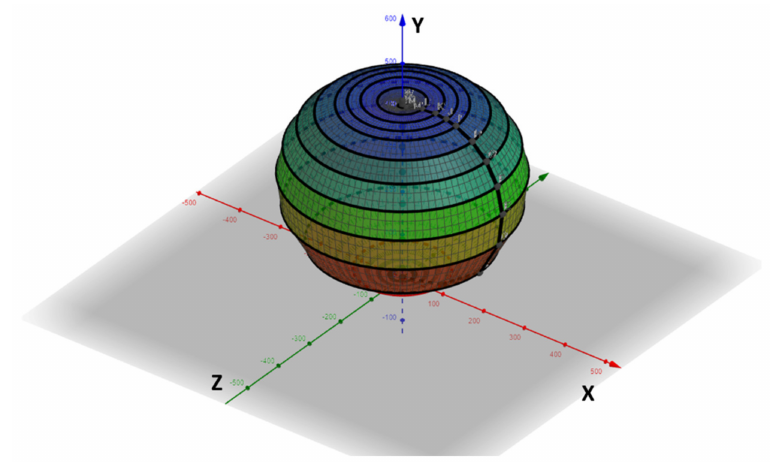
Figure 10. The manipulator’s volumetric workspace based on the simulation